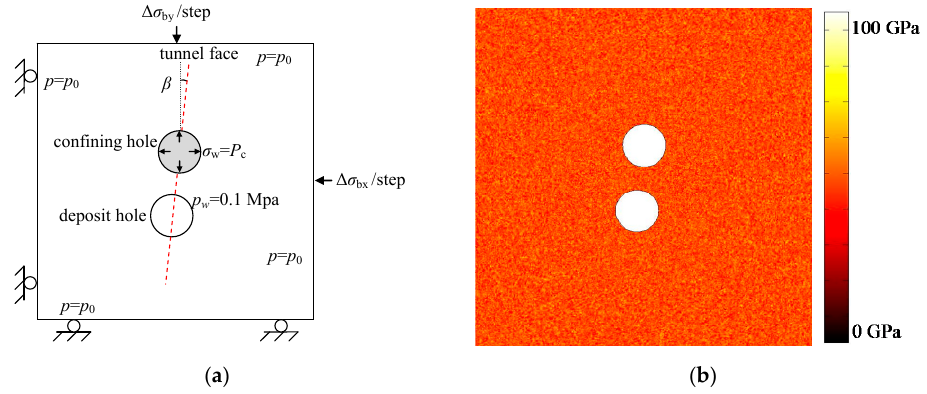
Figure 5. ( a ) The two-dimensional numerical model for APSE at excavation stage; ( b ) initial elastic modulus distribution. Materials 2016 , 9 , 841